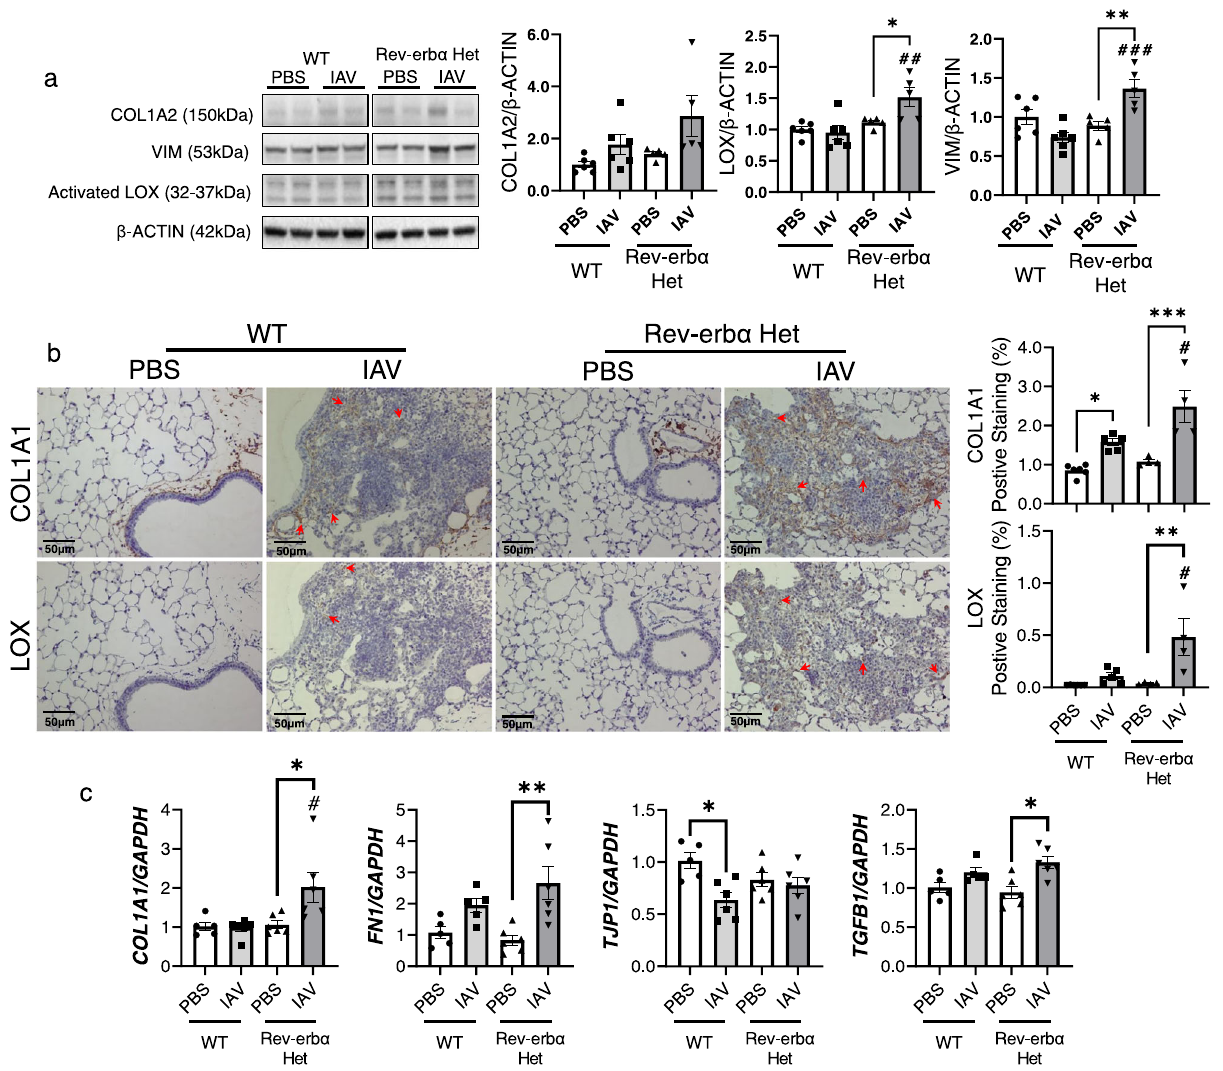
Fig. 7 | IAV infection induced dysregulation of pro fi brotic progression exa- cerbatedinRev-erb α Hetmice. WTandRev-erb α Hetmice(equalnumberofmale and female) infected (10 3 PFU/mouse) with IAV for 15 days, and lungs were sepa- ratedforRNA/proteinisolation,or fi xedwith10%formalinforFFPEsections. a The protein abundance of COL1A2, VIM and activated LOX were measured by western blot. Representative blot images were shown. Different targets were run on the same membrane: COL1A2, VIM and activated LOX were probed in the same membrane and β -ACTIN was used as an endogenous control ( n =5 – 6 mice per group). b The localizations of COL1A1 and LOX were determined by